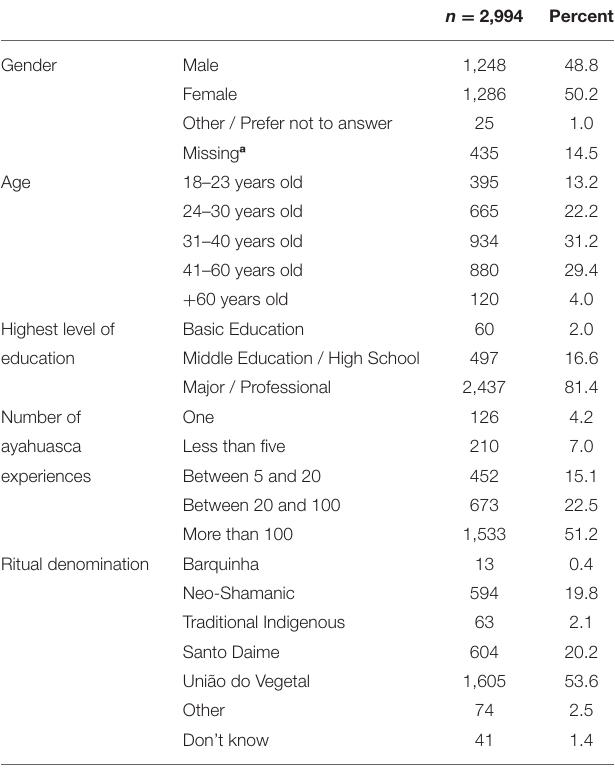
TABLE 2 | Demographic characteristics of the total sample.